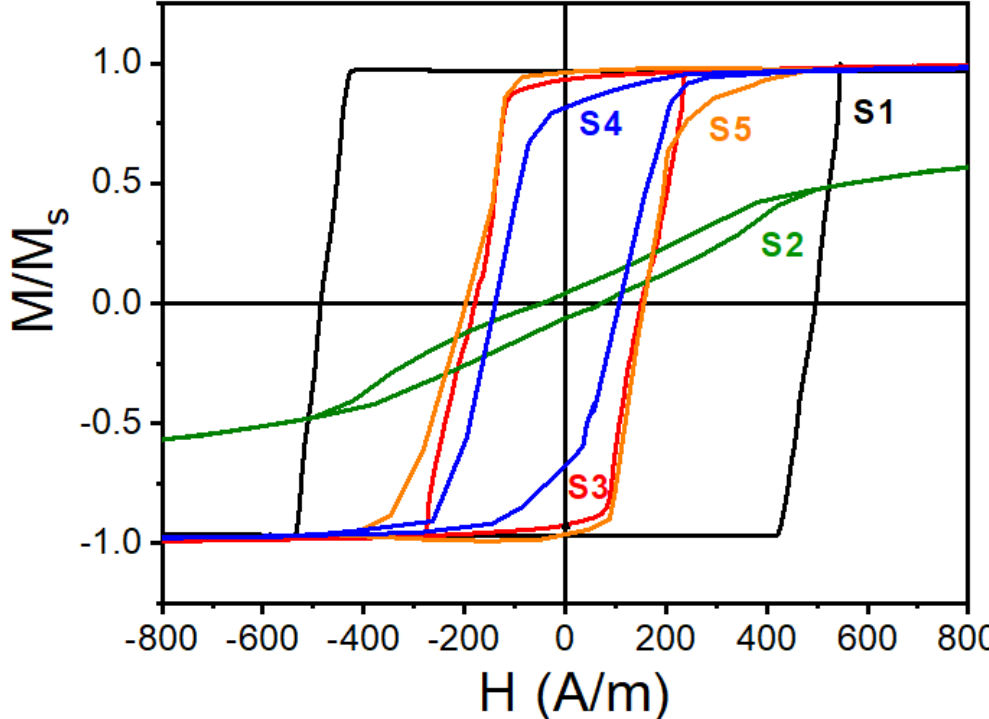
Figure 5. Hysteresis loops of individual microwires with composition of Fe 77.5 B 15 Si 7.5 in as-cast state (S1) and after different treatments (S2-S5). (S1) and after di ff erent treatments (S2–S5).